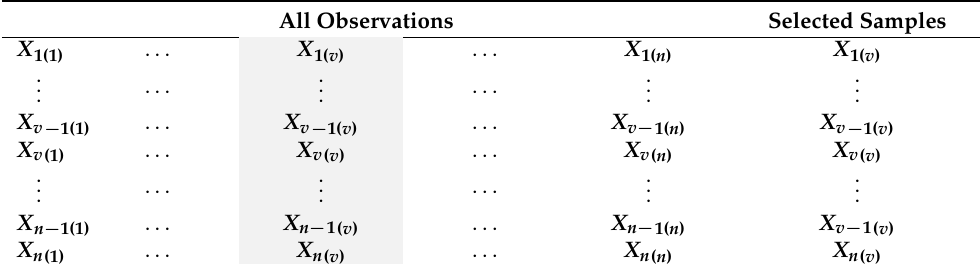
Table 1. Median ranked set sampling scheme with odd set